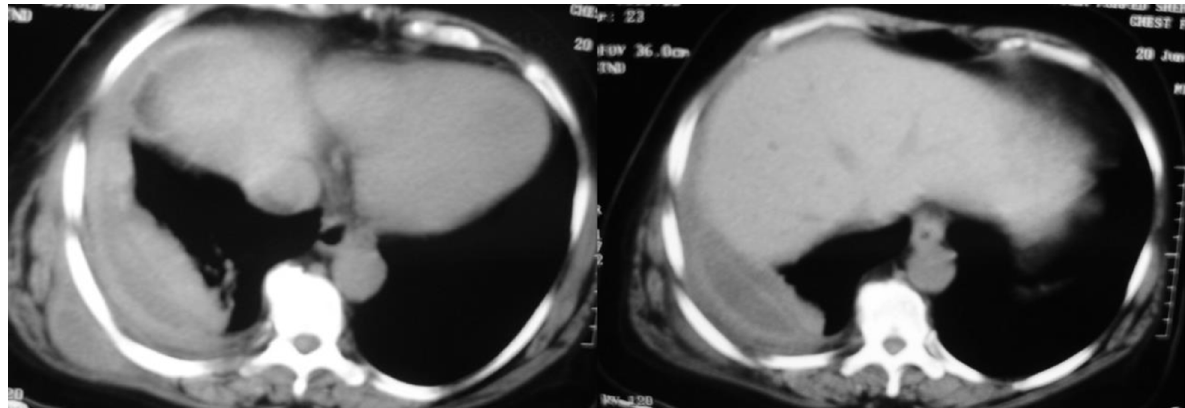
Fig. 9 45‑year‑old female patient presented with fever, chest pain and cough. Axial CT mediastinal window images showing a case of right basal empyema (split pleura sign), empyema necessitans and soft tissue expansion of the extra‑pleural